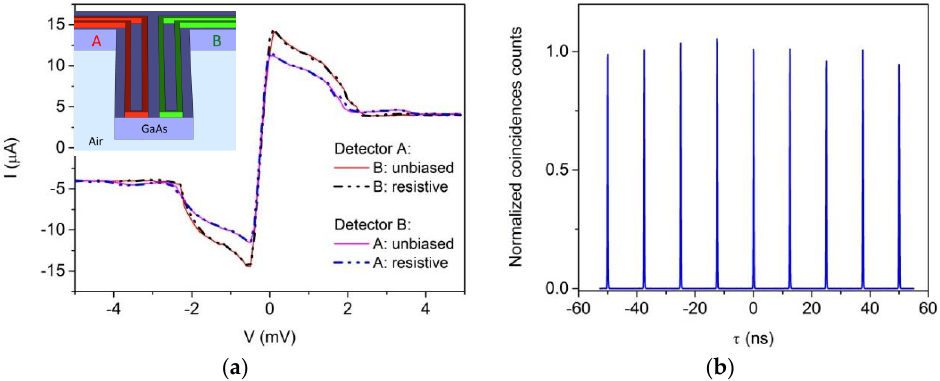
Figure 5. ( a ) I-V curve of Detector A while Detector B is unbiased or in resistive state; I-V curve of Detector B while Detector A is unbiased or in resistive state. Inset: sketch of the two independent SSPDs on top of SNB. ( b ) Coincidence rate under illumination with a 80 MHz pulsed laser at 965 nm and detectors biased at 97% I c .